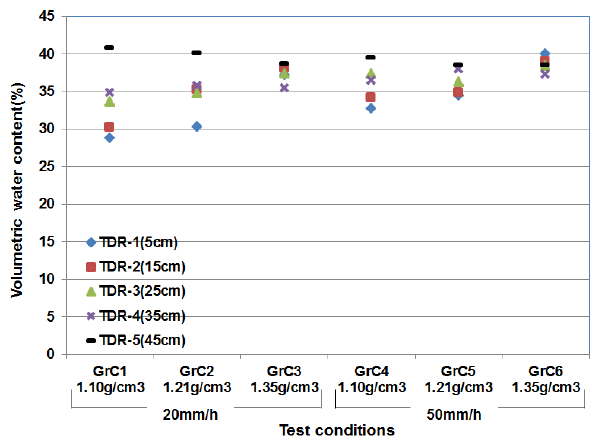
Figure 6. Maximum volumetric water content under each rainfall and unit weight soil condition at each depth.